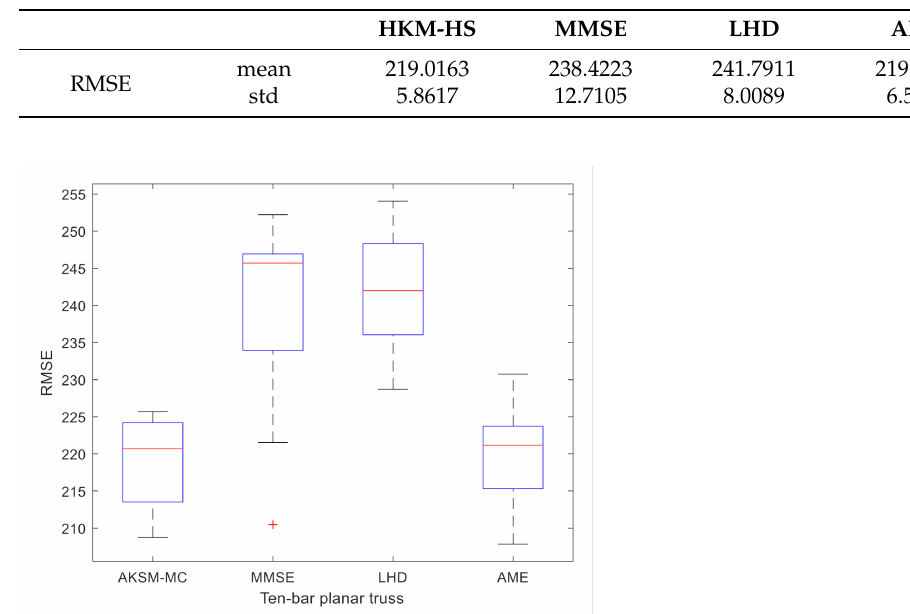
Table 7. Comparison of modeling results of ten-bar planar truss.